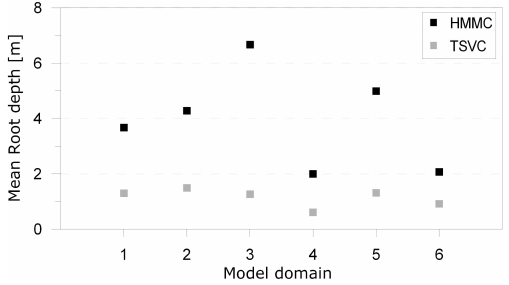
Fig. 17. Effective average summer root depths for the two optimised models for each mode domain.